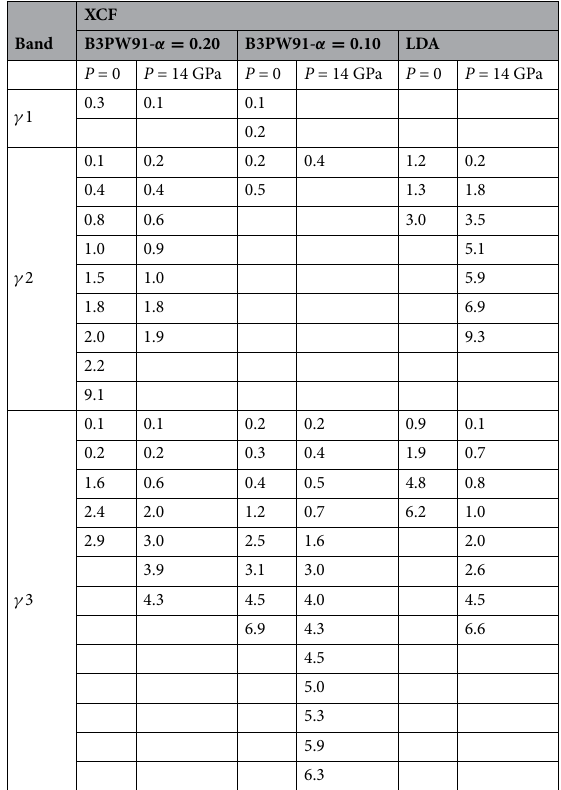
Table 1. dHvA frequencies of CeIn 3 Fermi surface branches at zero and 14 GPa pressures calculated by